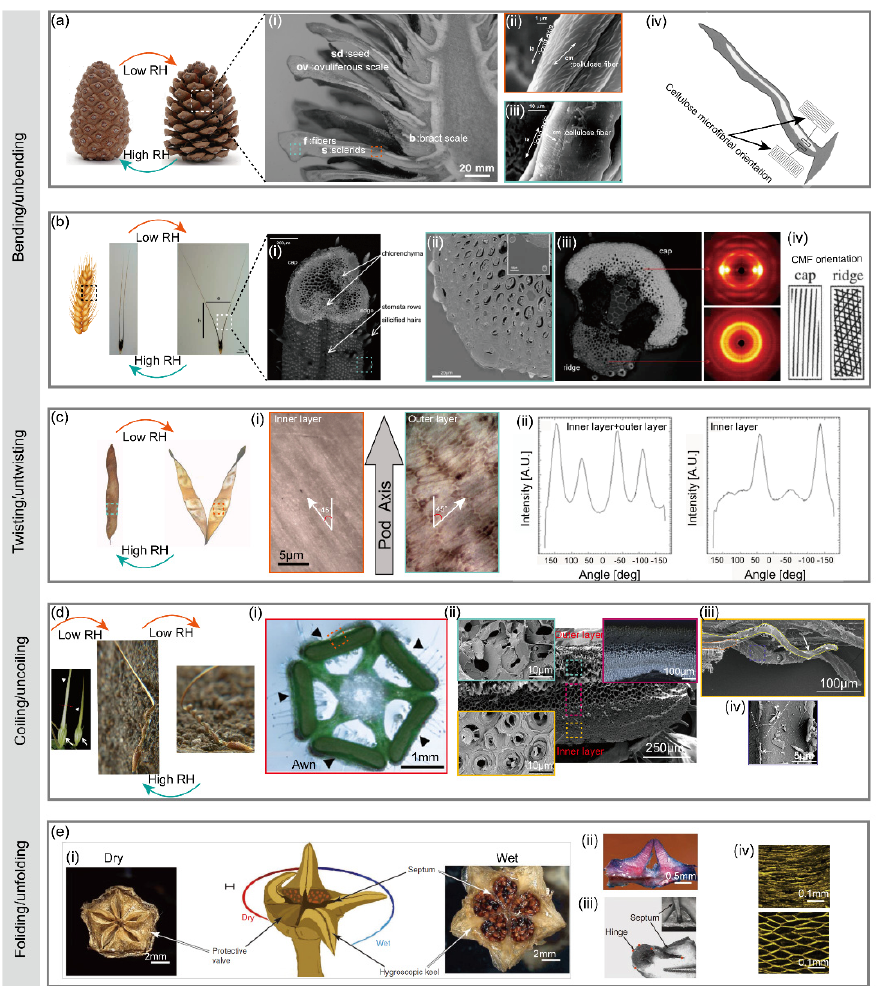
Figure 2. Hydronastic movements in plants and actuation mechanisms. ( a ) Bending/unbending of pinecone scale (reproduced with permission from Reference [9]). ( b ) Bending/unbending of wheat awn (reproduced with permission from Reference [10]). ( c ) Twisting/untwisting of seed pod (reproduced with permission from Reference [27]). ( d ) Coiling/uncoiling of stork’s bill (reproduced with permission from Reference [31]). ( e ) Folding/unfolding of ice plant valve (reproduced with permission from Reference [11]).